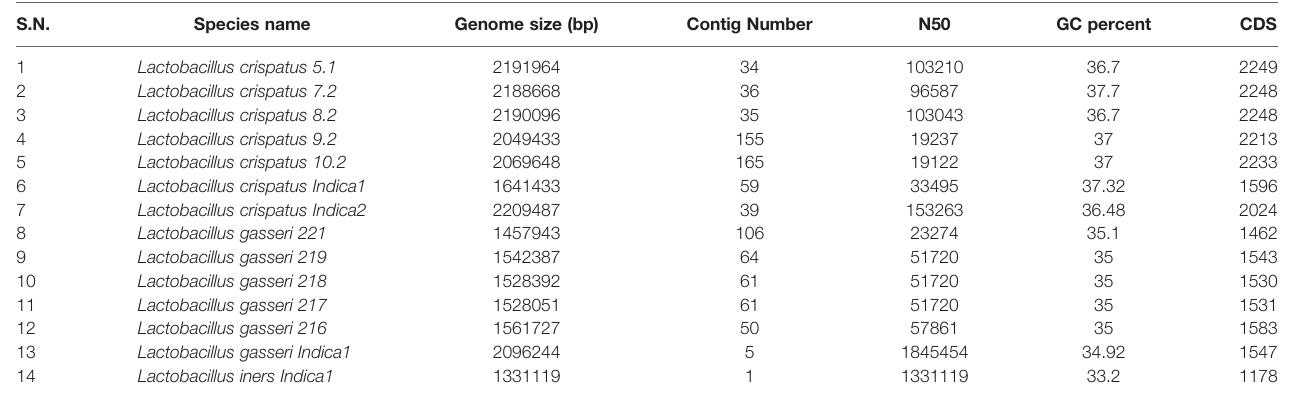
TABLE 5 | General genomic features of 14 Lactobacilli assembled genomes. S.N.